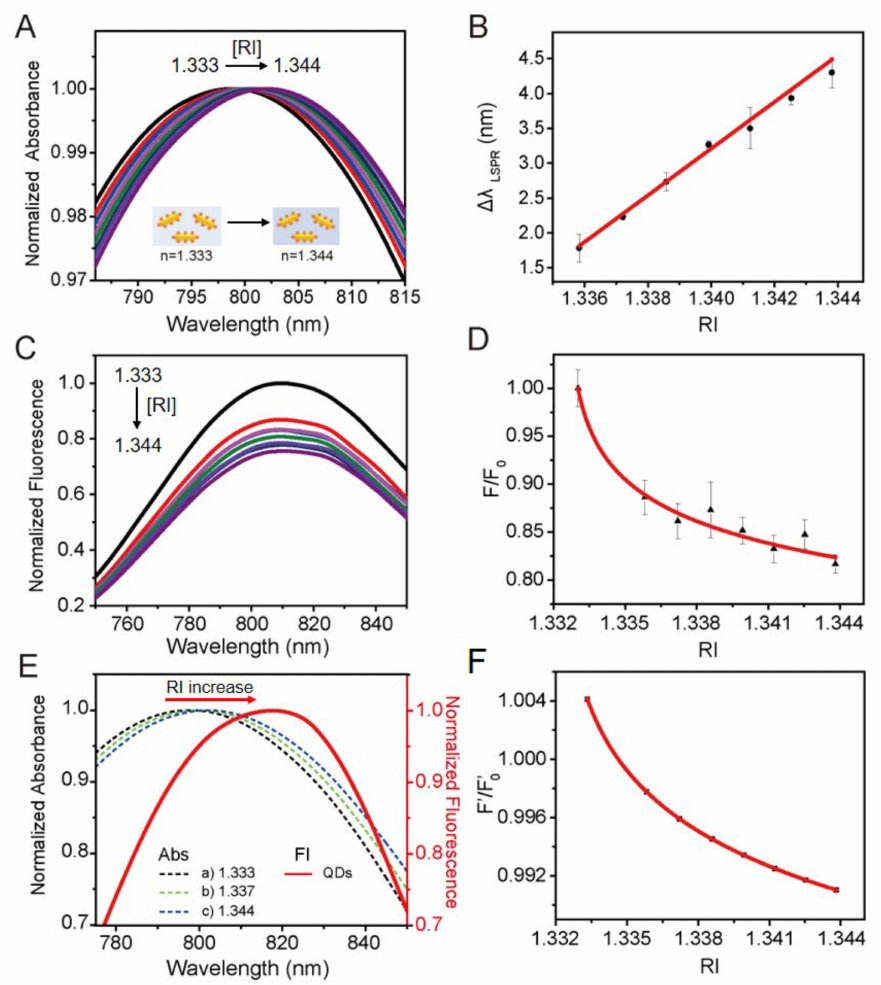
Figure 2. The response to refractive index (RI) for the plasmon-regulated FRET sensing system of Au NR-QDs. ( A ) Normalized UV-vis absorption spectra of Au NR-QDs in solutions with varying concentrations of water-glycerol mixtures with tuning environmental RI ( n = 1.333, 1.336, 1.337, 1.339, 1.340, 1.341, 1.343 and 1.344), respectively. ( B ) The ∆ λ LSPR for Au NR-QDs as a linear function of RI ( R 2 = 0.99) extracted from ( A ). ( C ) Normalized fluorescence spectra of Au NR-QDs in the same process as ( A ), where the maximum fluorescence intensity of Au NR-QDs when n = 1.333 was regarded as 1.0. ( D ) Relationship between the relative fluorescence intensity ( F / F 0 ) and environmental RI ( F / F 0 = 0.624( n − 1.332) − 0.06 , R 2 = 0.95). ( E ) Normalized absorption of Au NR-QDs with environmental RIof 1.333, 1.337, and1.344, respectively, and thenormalizedfluorescencespectraof QDs. ( F )Correlation between theoretical F / F 0 ( F’ / F’ 0 ) and environmental